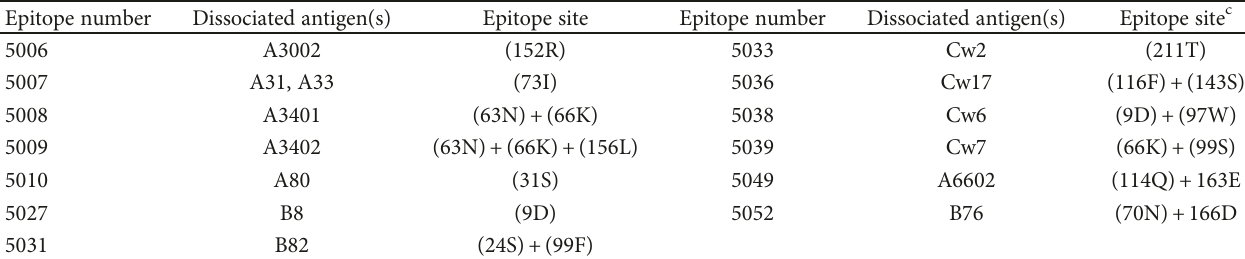
Figure 8: Epitope 38 shared by the ABC-loci antigens A2, A25, A26, A29, A31, A32, A33, A34, A43, A66, A68, A69, A74, B73, Cw7, and Cw17 and de fi ned by the amino acid glutamine (Q) at position 253. Table 4: Cryptic (C) epitopes on dissociated class I HLA antigen — partial list. Complete list in supplemental fi le. Epitope